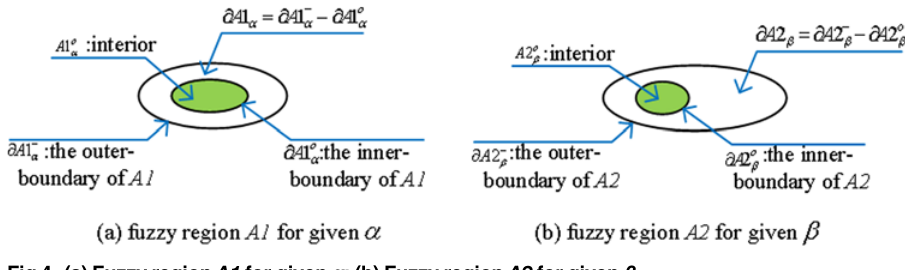
Fig 4. (a) Fuzzy region A1 for given α ; (b) Fuzzy region A2 for given β